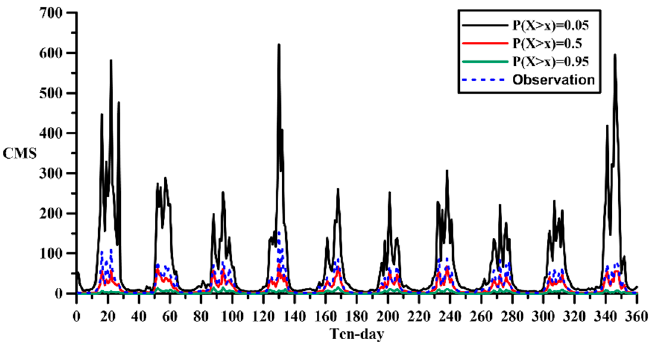
Figure 15. Comparisons of 10-year flow data with Method I. P(X > x): probability of exceedance.